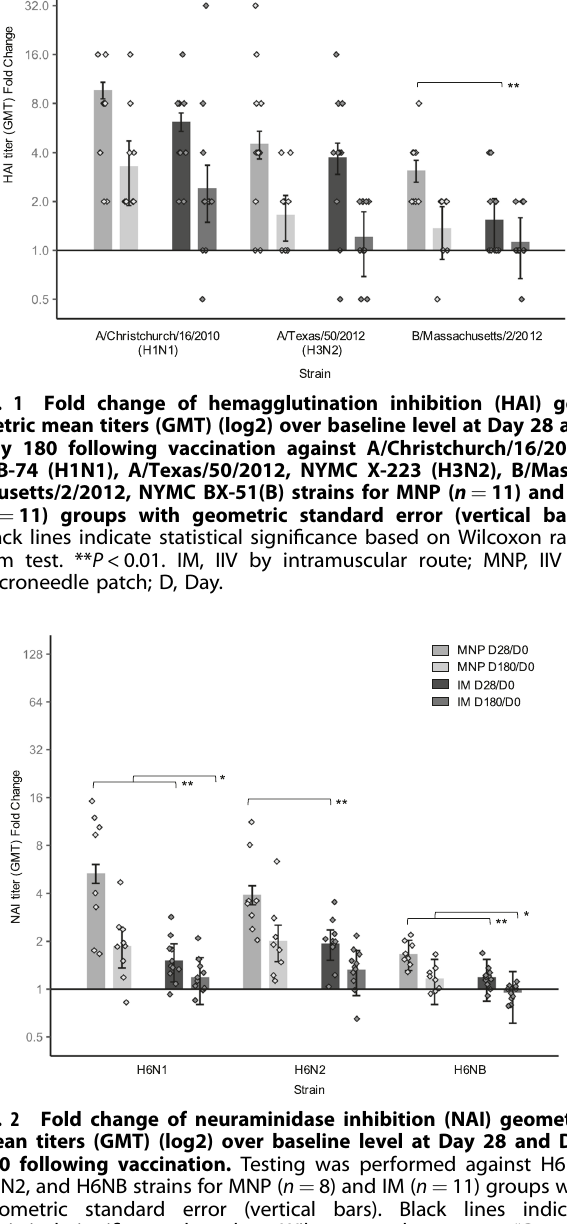
Table 1. Demographic characteristics of participants ( n = 22) a .